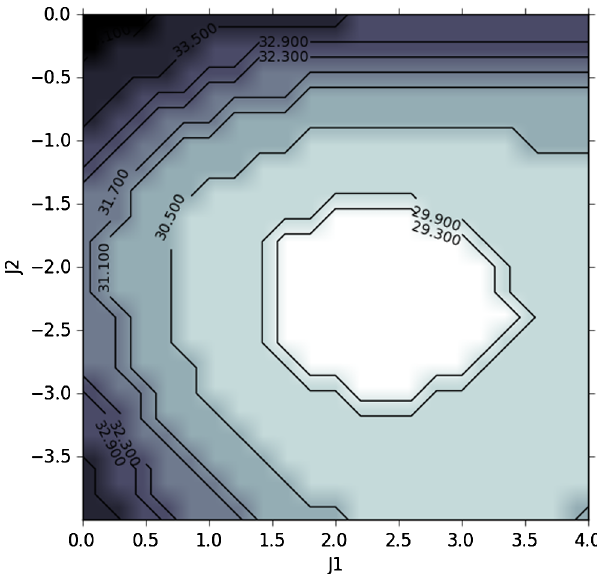
FIG. 6. Convergence time of the s-BP algorithm with L ¼ 2 as and J (in log scale) for Gauss-Bernoulli signal a function of J 1 2 ¼ 0 : 1 . The color represents the number of iterations with (cid:2) 0 such that the MSE is smaller than 10 (cid:5) 8 . The white region gives the fastest convergence. The measurement density is fixed to (cid:1) ¼ 0 : 25 . The parameters in s-BP are chosen as L ¼ 2 and ¼ 0 : 3 . The axes are in log (cid:1) scale. 1 10